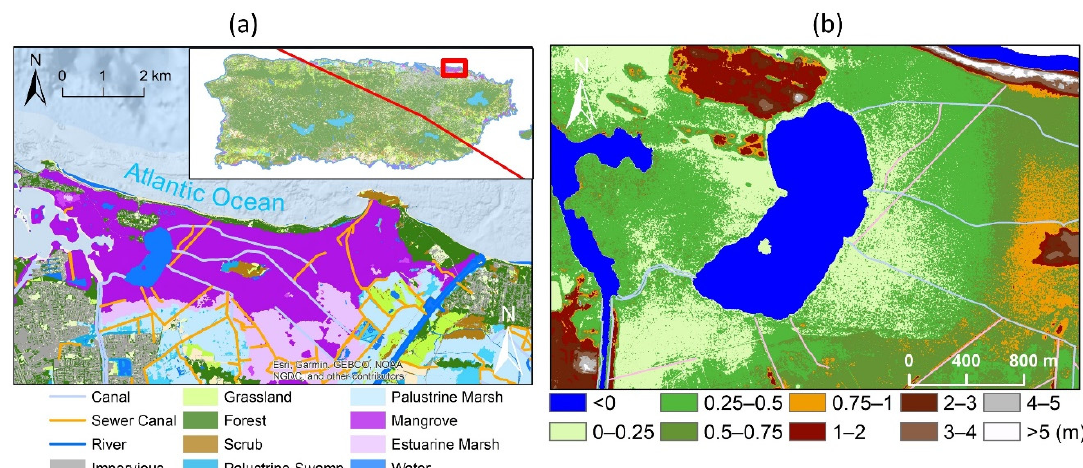
Figure 1. ( a ) Piñones State Forest, the largest mangrove forest in Puerto Rico. Map of Puerto Rico is in the upper right with a red line indicating the path of Hurricane Maria on 20 September 2017. Land cover from the NOAA C-CAP Program for 2010 shows the distribution of mangroves, together with the rivers and canals. ( b ) Digital Elevation Model around the Piñones Lagoon, also with the canals.